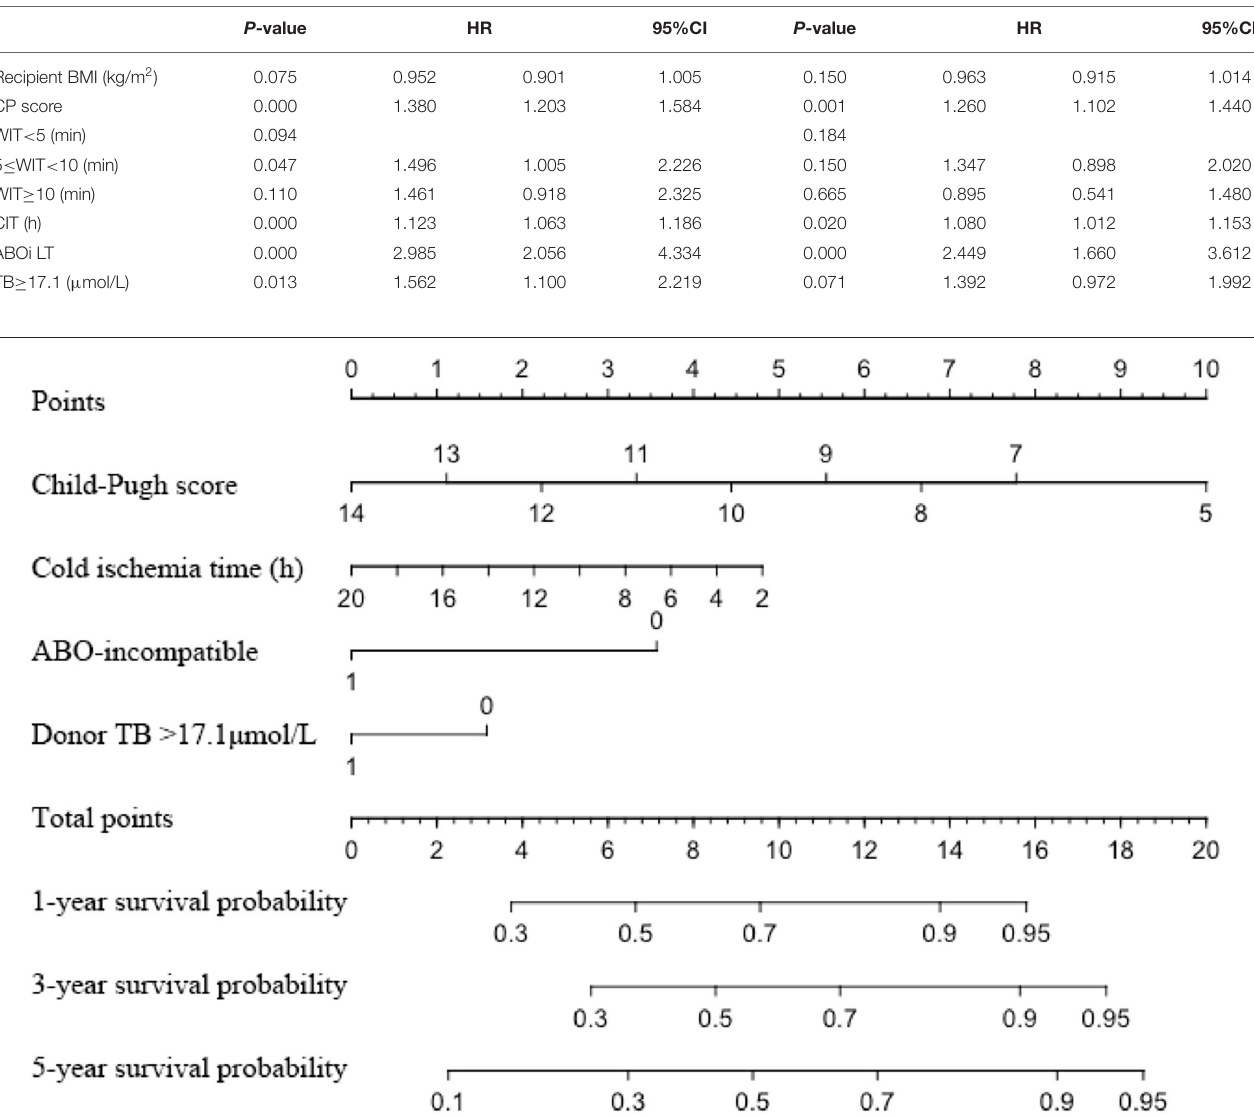
TABLE 4 | Univariate and multivariate cox analysis of risk factors associated with graft loss. P -value HR 95%CI P -value HR 95%CI